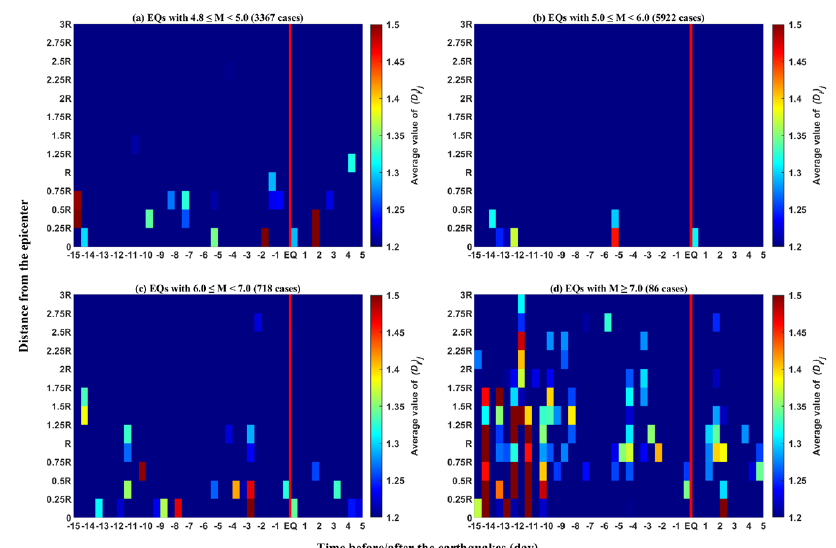
Figure 5. Same as in Figure 4 but for earthquakes with different magnitudes, including EQs with M ≥ 4.8 and M < 5 ( a ), EQs with M ≥ 5 and M < 6 ( b ), EQs with M ≥ 6 and M < 7 ( c ), and EQs with M ≥ 7 ( d ).